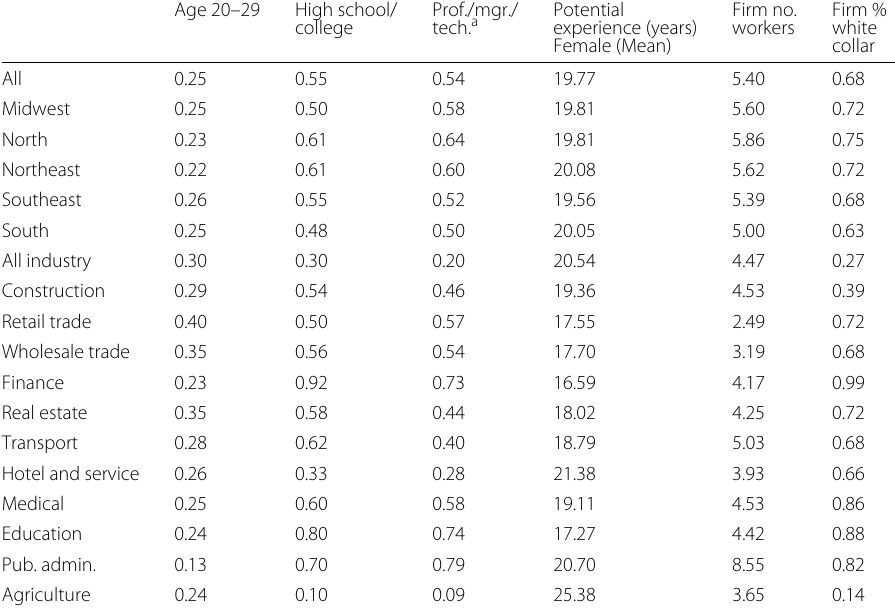
Table 9 Female characteristics and gender differences, by region and